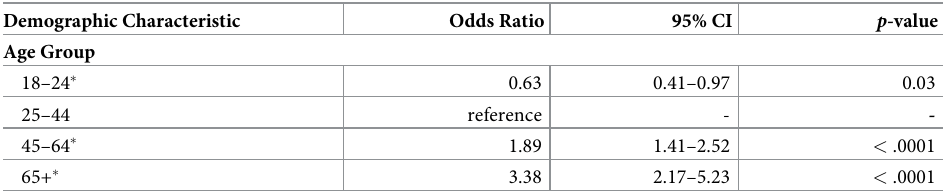
Table 4. Odds of providing a mailing address at the time of Healthy NYC enrollment (n = 8,110) 1, �� .